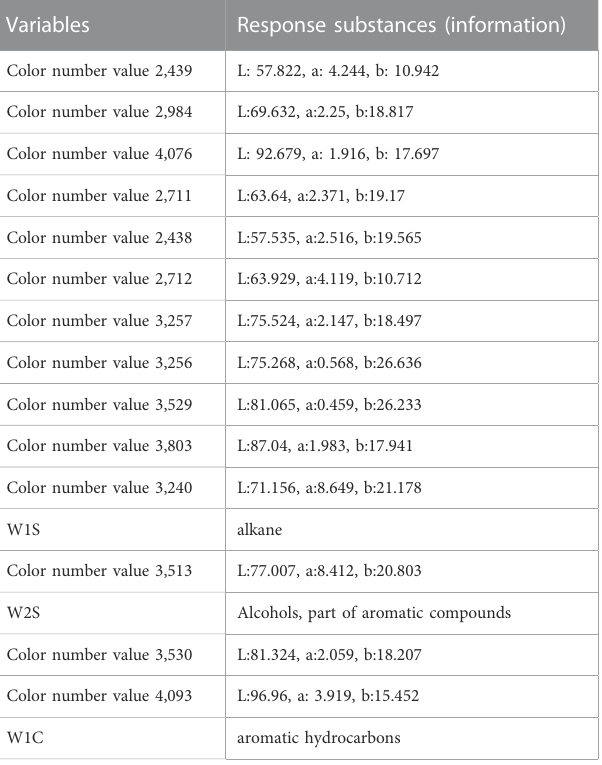
TABLE 5 Variables selected based on Wilk ’ s lambda values and their response substances.